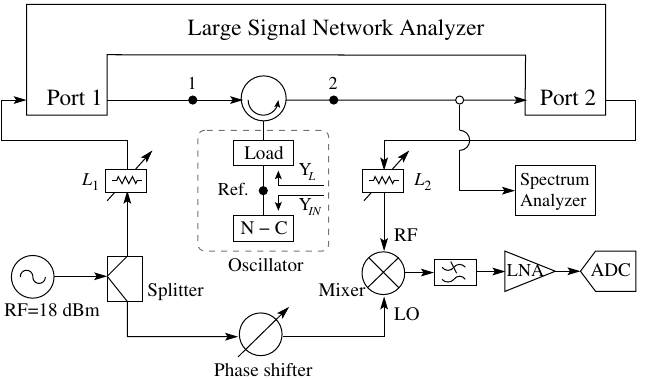
Figure 2. Previous additive phase noise measurement system in [19] integrated with an LSNA for a two-port injection-locked oscillator. N-C stands for the negative-conductance circuit.